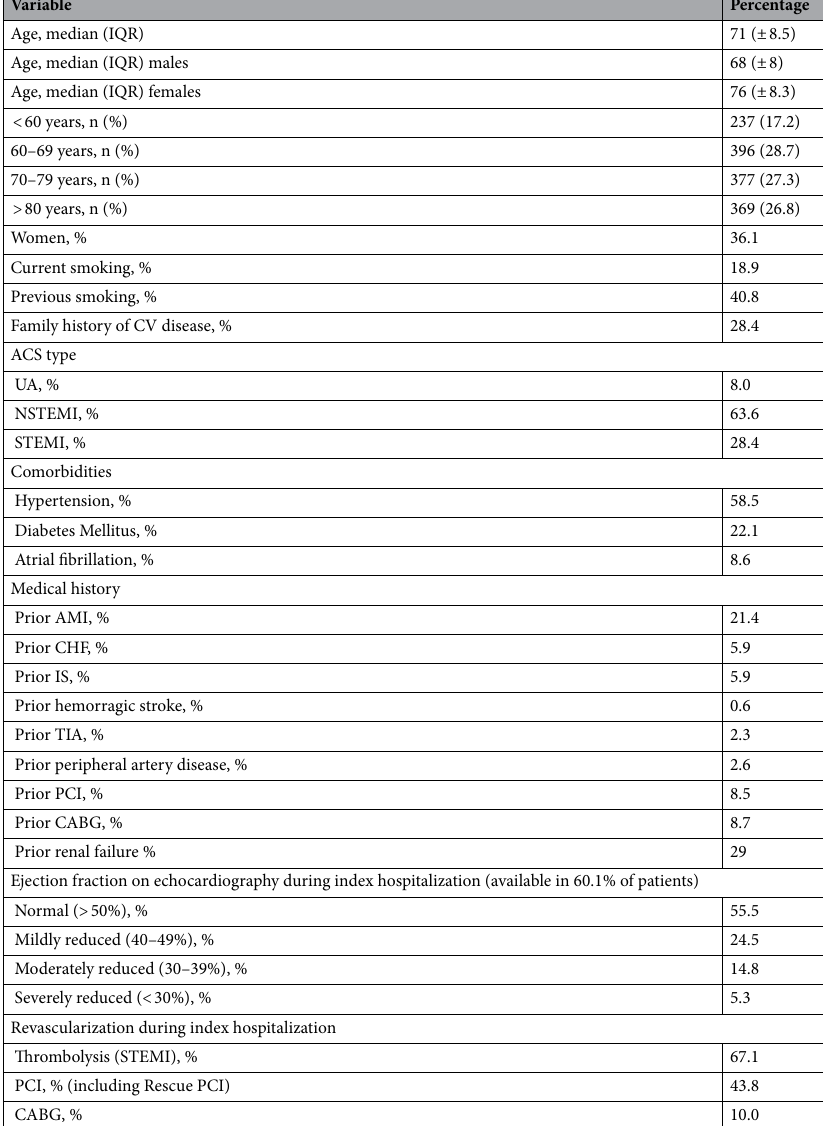
Table 1. Baseline patient characteristics among 1379 patients discharged after hospitalization for ACS. CV cardiovascular, UA unstable angina, NSTEMI non-ST-segment elevation myocardial infarction,